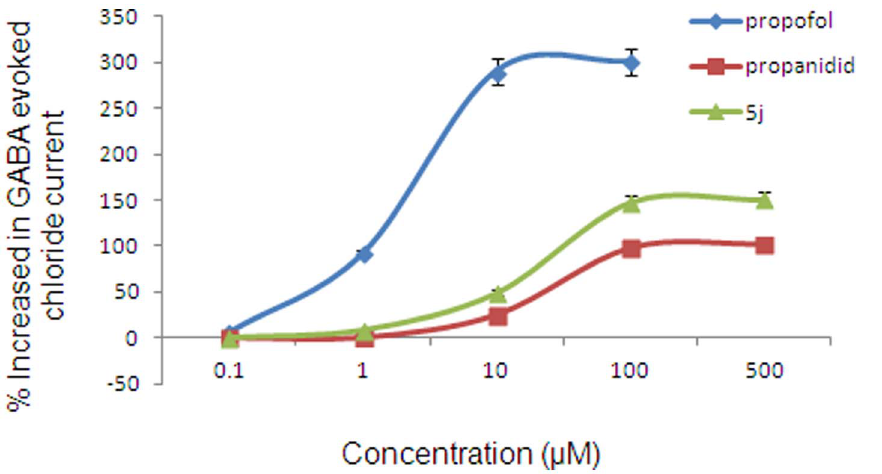
Figure 7. Potentiation of EC 20 muscimol evoked chloride currents in GABA A ( a 1 b 2 c 2 ) CHO-K1 cell. Data were expressed as the means 6 SD. EC 50 = concentration producing 50% of maximal effect. doi:10.1371/journal.pone.0096518.g007 NMR (CDCl 3 ) d 0.92 (t, 3H, J= 7.46 Hz), 1.14 (t, 3H, J=7.10 Hz), 1.22 (t, 3H, J= 7.10 Hz), 1.61–1.69 (m, 2H), 3.38–